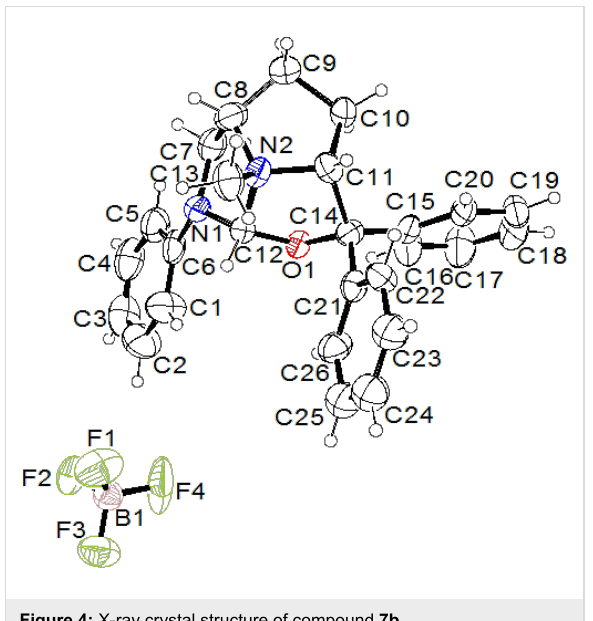
Figure 4: X-ray crystal structure of compound 7b .